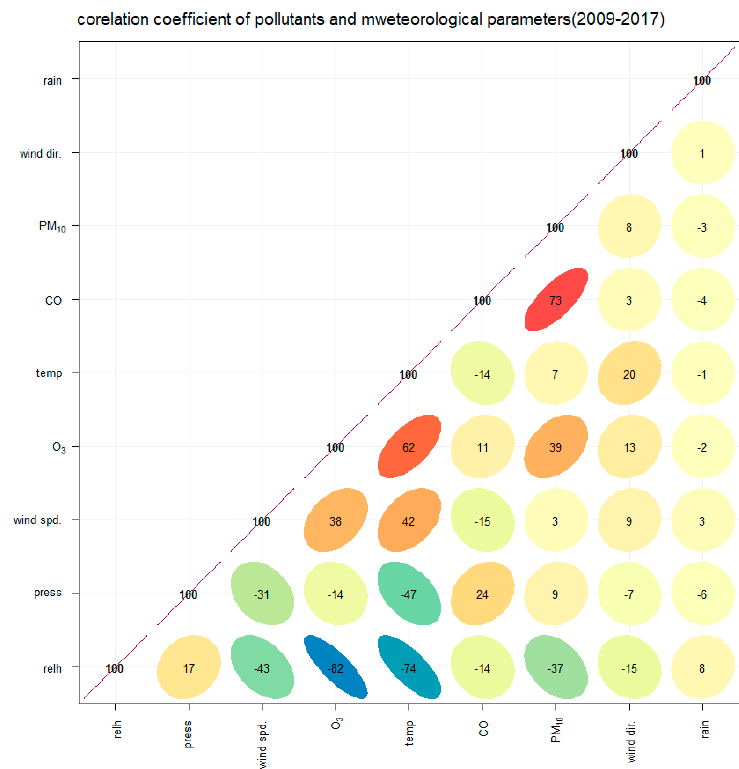
Figure 4. Correlation coeeficients of pollutants and meteorological parameters for 2009–2017.